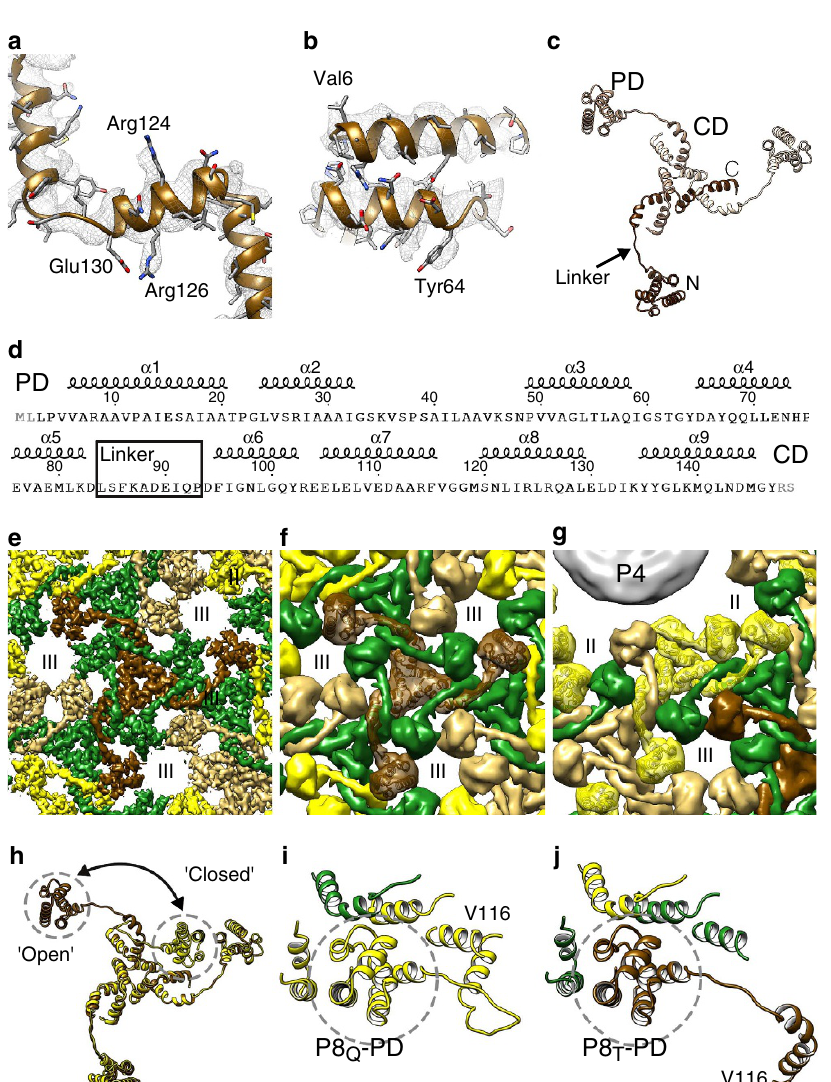
Figure 2 | Domain swapped architecture of the outer / 6 P8 shell. ( a , b ) Close-ups of the atomic model of the T-type trimer (P8 T ) and corresponding density (mesh). Some side chains are labelled. ( c ) Atomic model of the P8 trimer. The three different chains are shown in different shades. The peripheral domain (PD) and the core domain (CD) are labelled and the corresponding areas of the structure circled. The linker (arrow), N terminus (N) and C terminus (C) are labelled for one chain (dark brown). ( d ) Sequence of the P8 with secondary structure elements, PD, CD and the linker region labelled. Amino-acid residues not resolved in the structure are in grey. ( e ) A close-up of the P8 shell density viewed along the three-fold axis of symmetry. The linkers from different trimers intertwine, leading to domain swapping of the peripheral domains between the trimers. ( f ) Same view as in e but a rough molecular surface is shown for clarity. P8 T is shown as a ribbon. ( g ) Same as f but a view showing the Q-type trimers (P8 Q , ribbon) around the P4 hexamers. P4 is shown as a grey surface. ( h ) Structural alignment of P8 T and P8 Q trimers. The location of the peripheral domain in ‘open’ and ‘closed’ conformation of the trimer is indicated. ( i ) The mode of interaction of P8 Q -PD in closed conformation is shown. The interactions are mainly of homotypic nature with other parts of the same trimer. ( j ) The mode of interaction of the P8 T -PD in open conformation is shown. The interactions are of heterotypic nature with other types of trimers. The P8 trimers are coloured in yellow (P8 Q ), green (P8 R ), gold (P8 S ) and brown (P8 T ) and the type II and type III holes 23 are labelled. See also Supplementary Figs 2 and